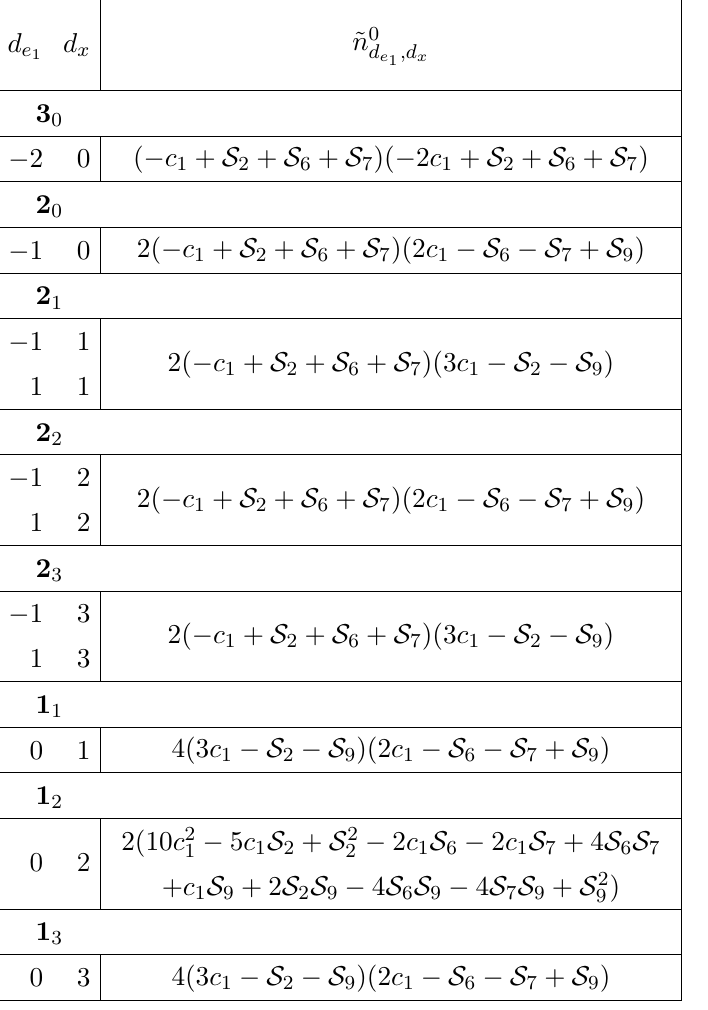
Table 9 . Base independent fiber Gopakumar-Vafa invariants for fibrations with generic fiber real- ized as nef partition (5 ; 3)